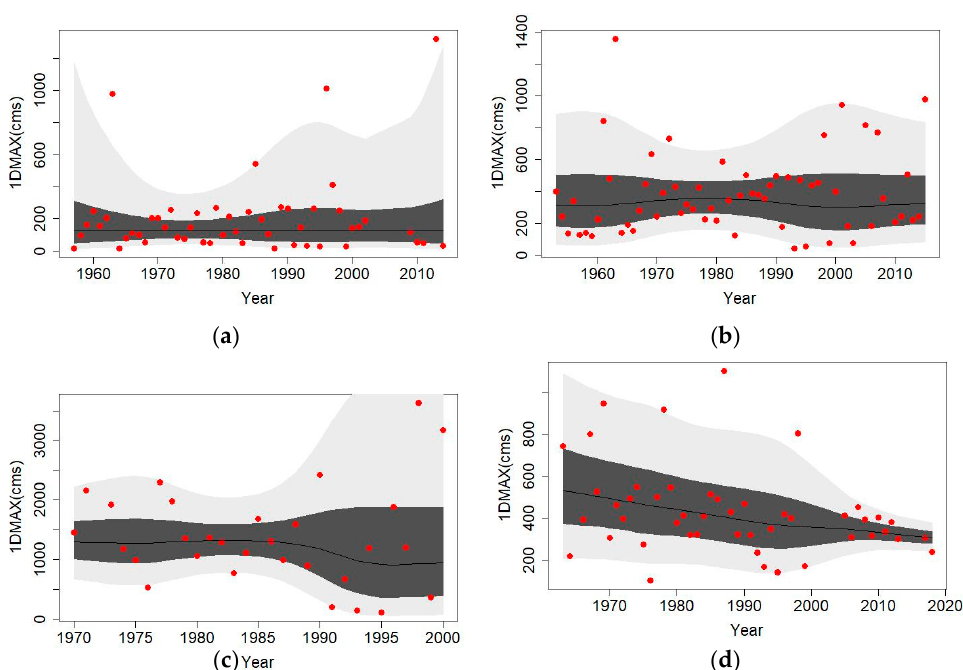
Figure 4. Variations of quantile curves (0.95, 0.75, 0.5, 0.25, and 0.05 from top to bottom) of 1DMAX (annual maximum 1-day streamflow) at ( a ) H1 (Xiuluan), ( b ) H4 (Fushan), ( c ) H5 (Xiulang), and ( d ) H7 (Wudu).